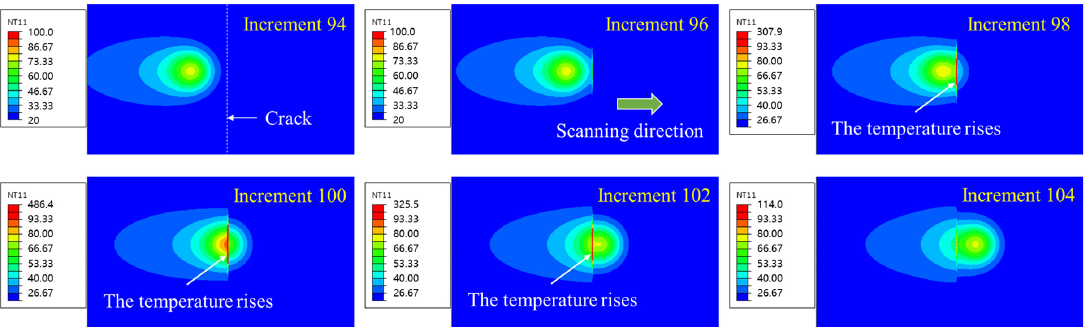
Figure 5. Surface temperature distribution at different frames when a laser scans through a crack.